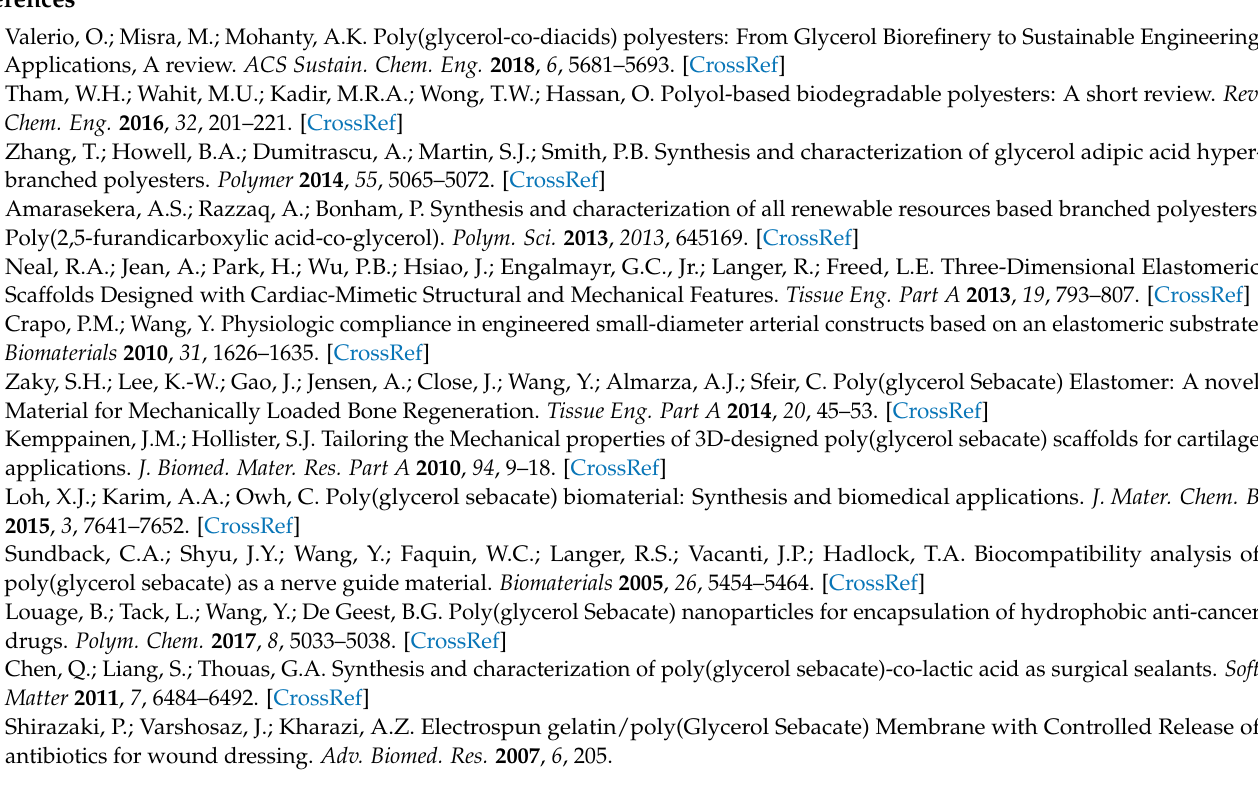
enlargement; Figure S5: FT-IR spectrum of PGS9; Figure S6: Cyclic voltammograms (CV)